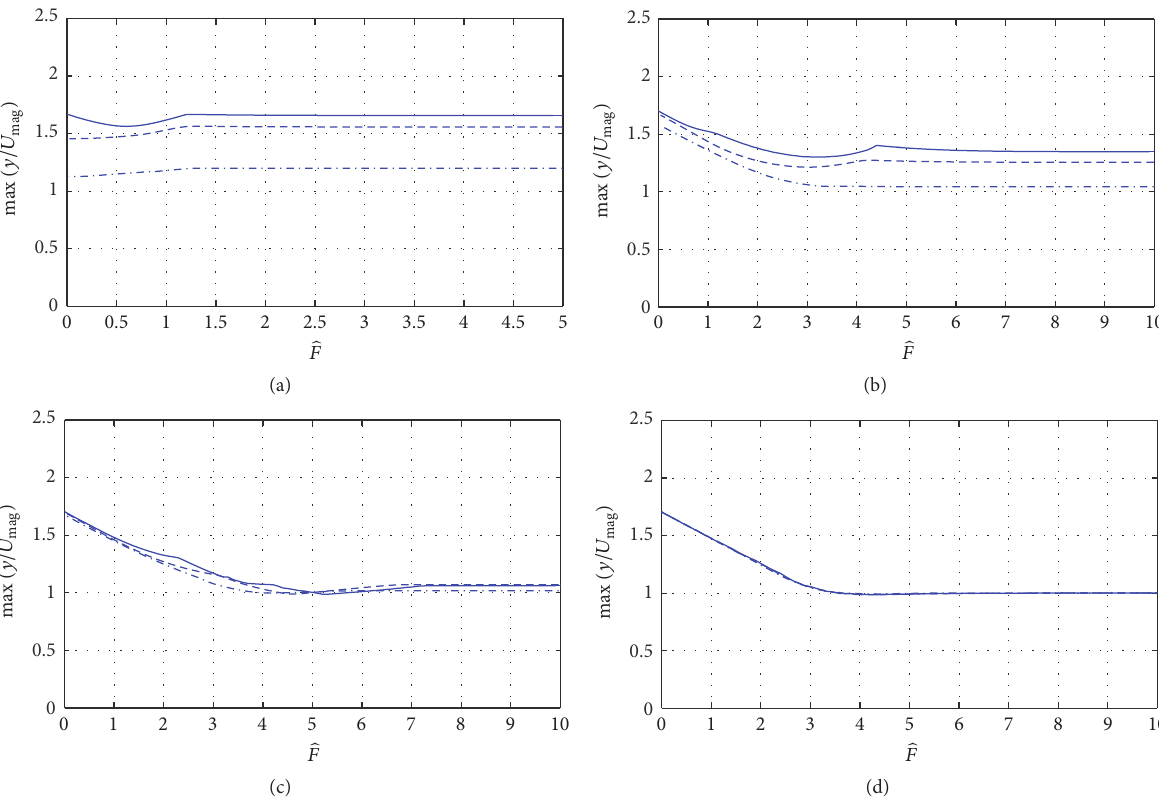
Figure 8: The maximum displacement response of the primary mass in the friction system under a versed sine base input for different levels ̂𝑘 ̂𝑘 = 0.4 ̂𝑘 = 2.5 ̂𝑘 = 10 ̂𝑘 = 250 of friction. Stiffness ratio : (a) , (b) , (c) , and (d) . Mass ratio 𝜇 = 0.1 (solid line), mass ratio 𝜇 = 0.32 (dashed line), and mass ratio 𝜇 = 1 (dash-dotted line). Pulse length 𝑇 𝑝 = 𝑇 1 , nondimensional base input magnitude 𝑈